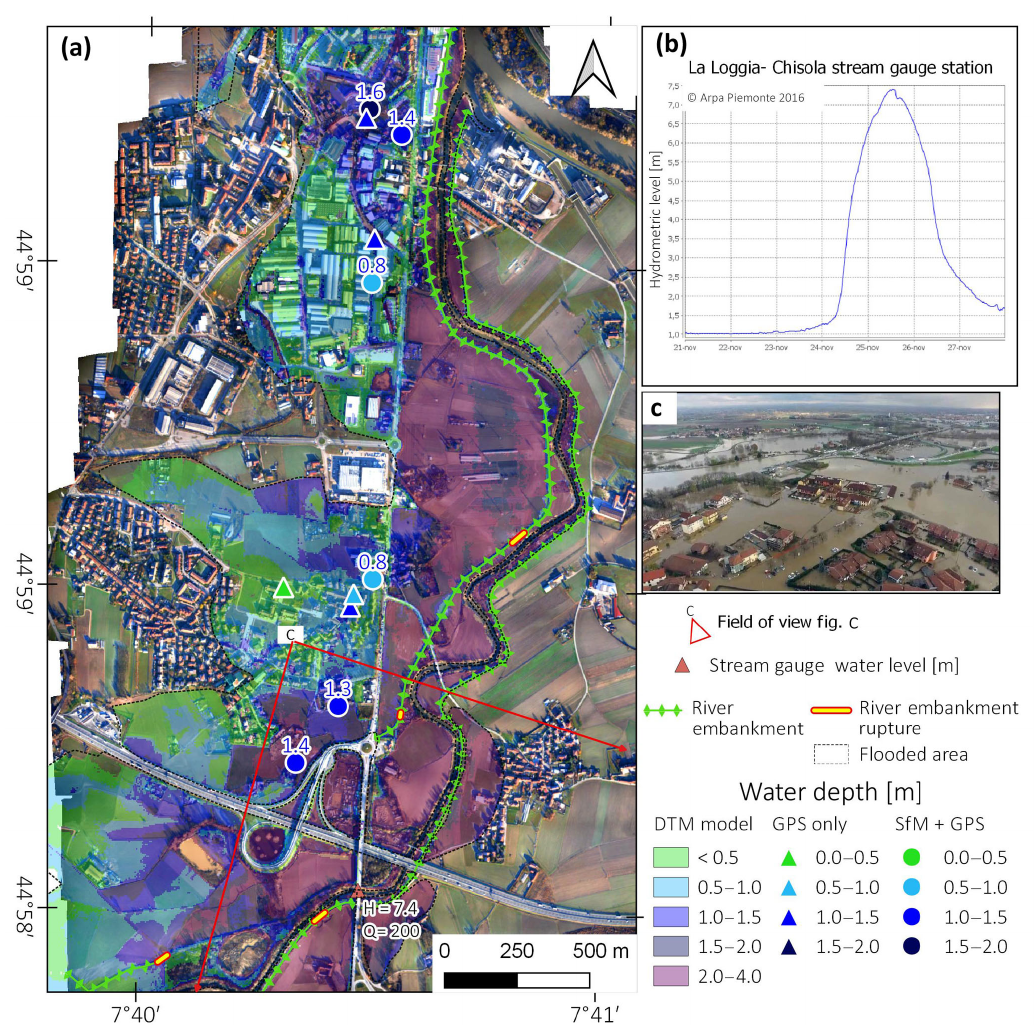
Figure 11. (a) Water depth levee map based on SfM data and 5m DTM model. (b) Water level reached by Chisola Stream in ARPA Piedmont station. (c) Geolocated third part photo: 25 November 2016 aerial view of flooded area found on the web (https://vivere-moncalieri.it/2016/ 11/30/3760/, last access: 23 May